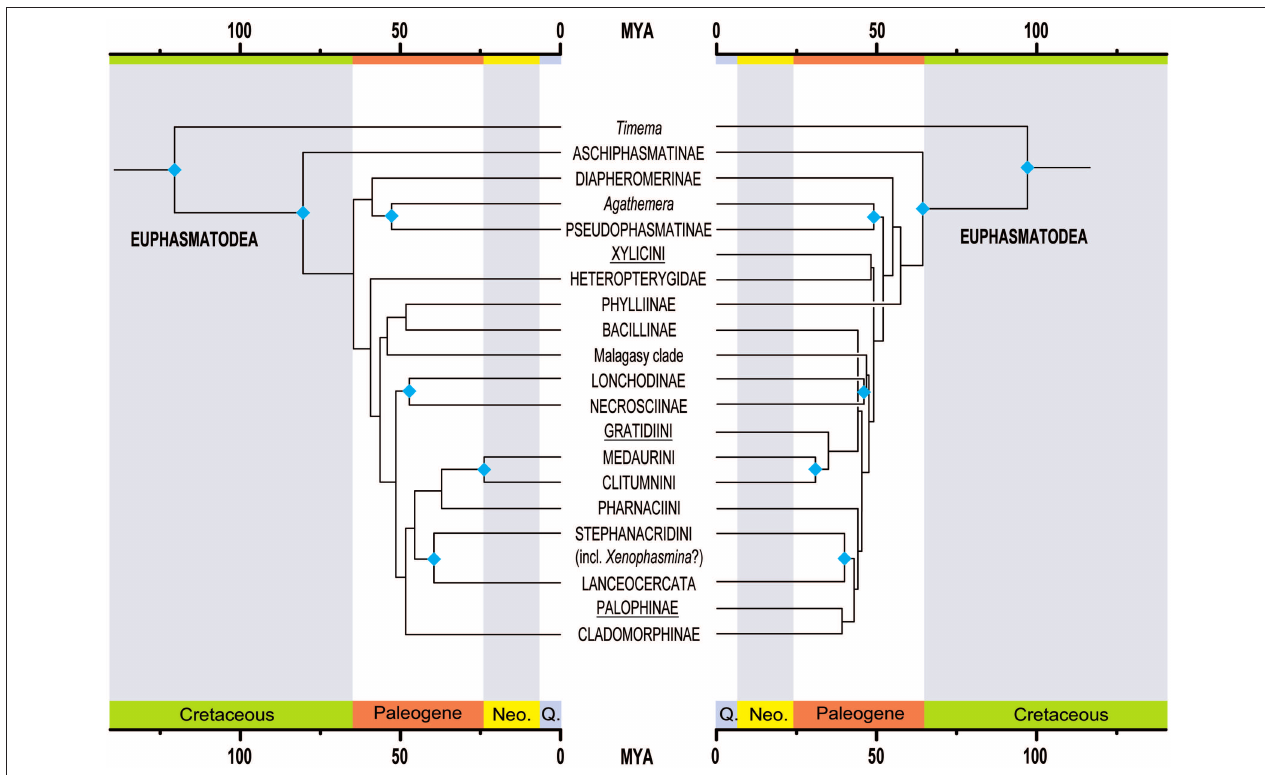
FIGURE 3 | Comparison of topology and divergence time estimations between the herein presented new phylogeny of Phasmatodea (left side) to the most recent and comprehensive phylogeny based on Sanger sequence data by Robertson et al. (2018). The underlined taxa are African lineages included in the study from Robertson et al. (2018) but missing in the present study. The blue rhomb symbols indicate taxa supported in both studies. Neo., Neogene; Q.,